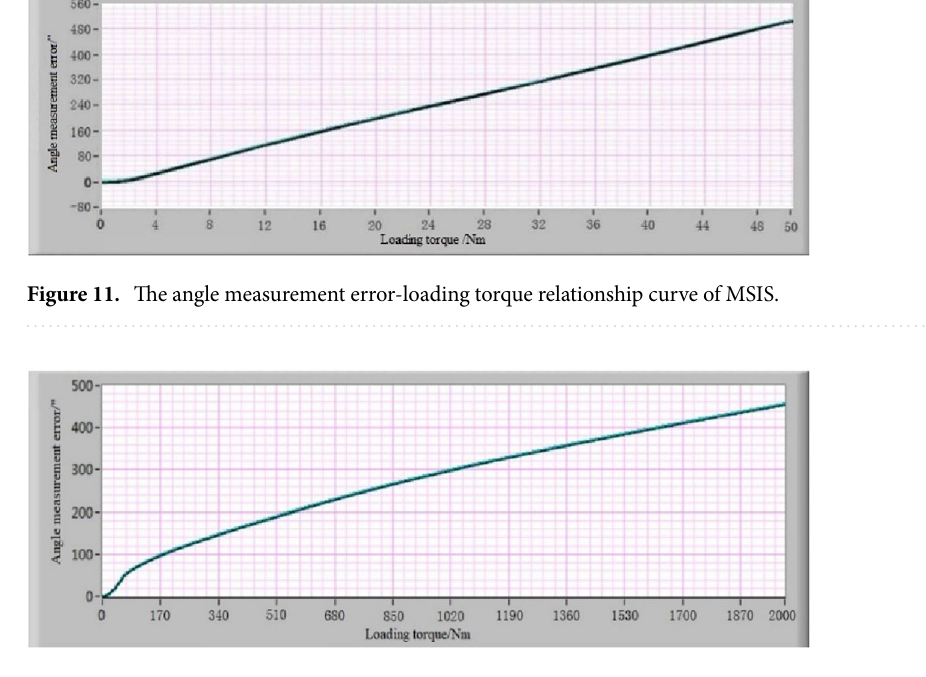
Figure 12. The angle measurement error-loading torque relationship curve of